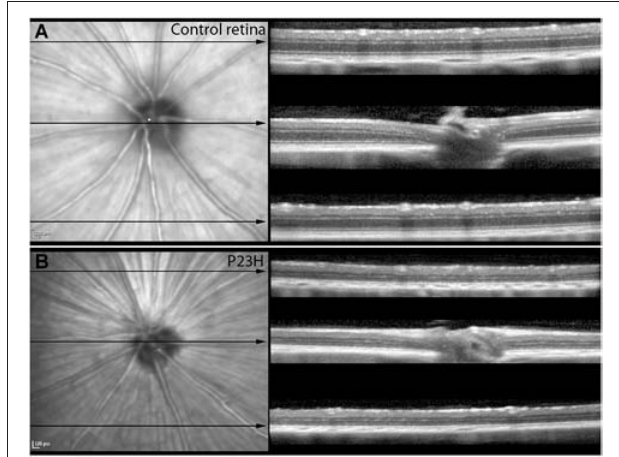
FIGURE 4 | Red-free images and OCT sections of control and P23H pigmented L1 . Red-free images and OCT sections of control rats (A) and P23H pigmented line 1 at P130 (B) . Red-free image showed the optic nerve and the major retinal vessels. The three sections showed the decreased thickness in the P23H rats, with a clear reduction of the ONL layer and changes in the hyperreflective layer. Note that the IPL is well preserved in the RP